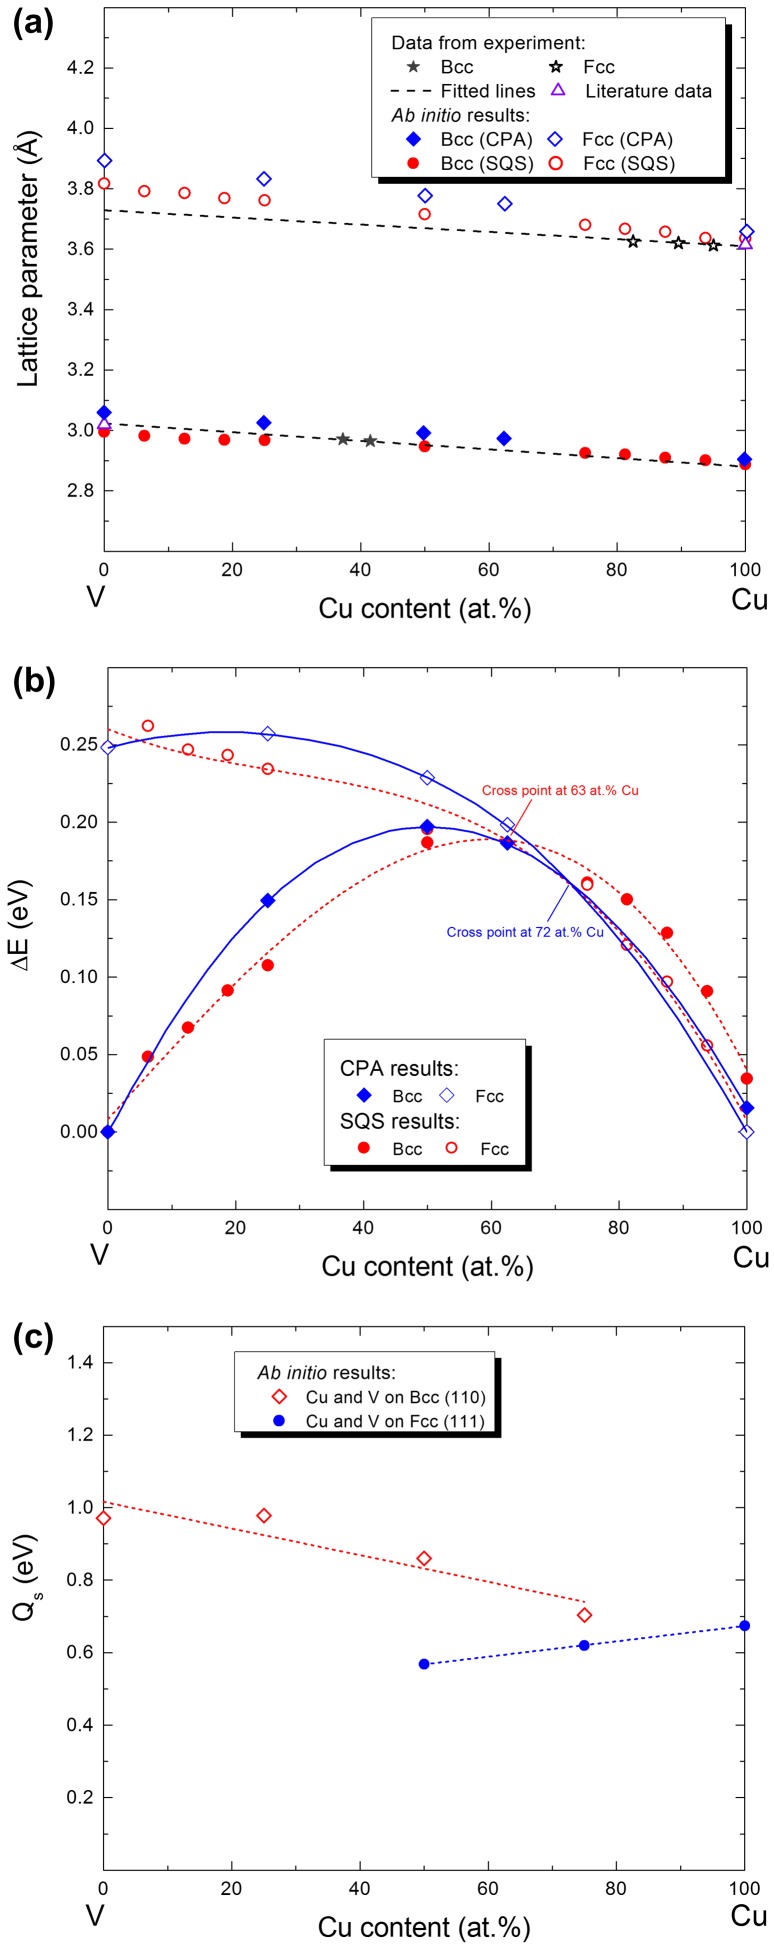

Ab initio results of CuxV1-x as a function of composition: (a) lattice parameters (compared with experimental data), (b) formation energies (ΔE) of bcc and fcc phases, (c) activation barriers (Q
s) of Cu and V atoms at bcc (110) and fcc (111) surfaces. Experimental lattice parameters of fcc-Cu and bcc-V are taken from [52,53].